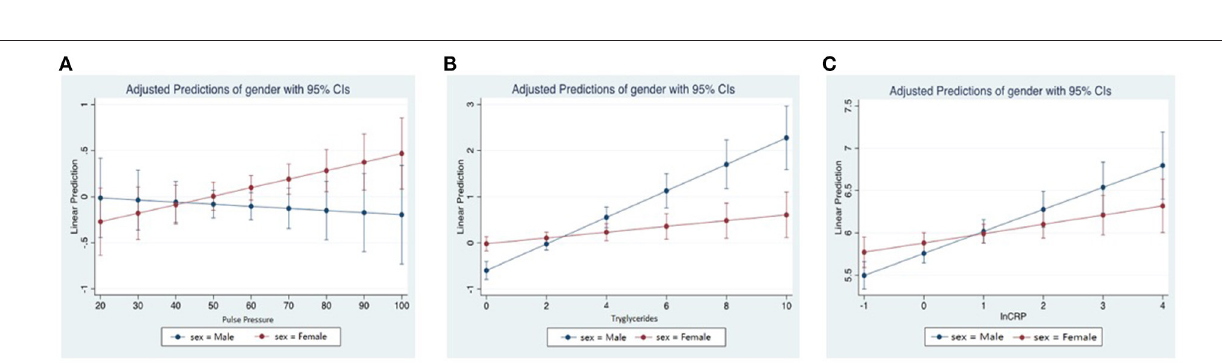
(19), although a distinction between sex has not been